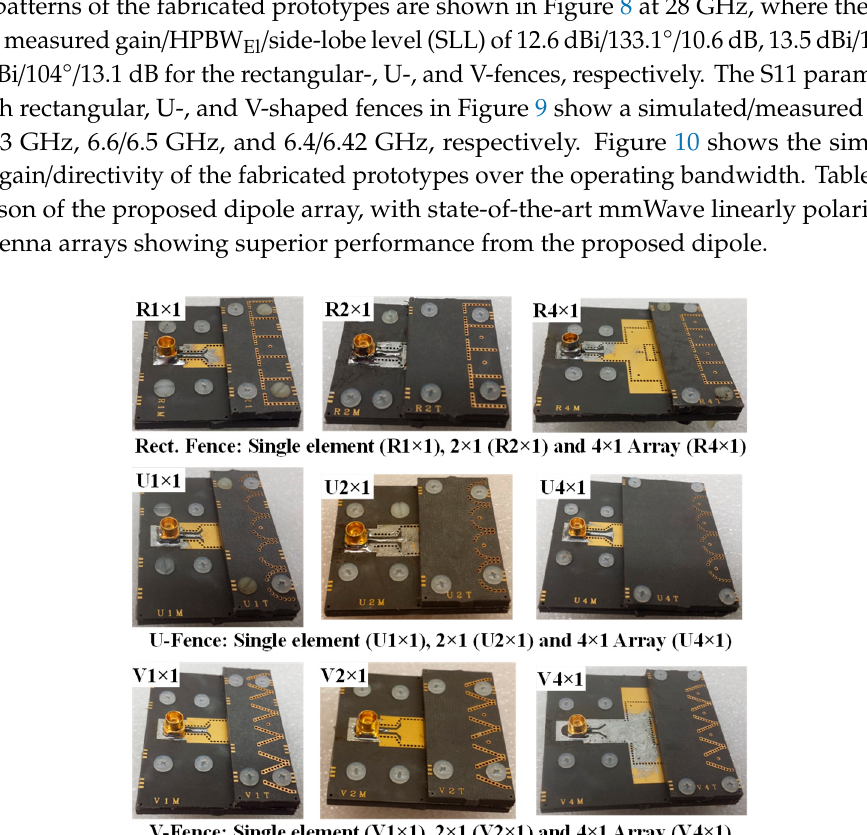
Figure 7. The fabricated antennas prototypes.